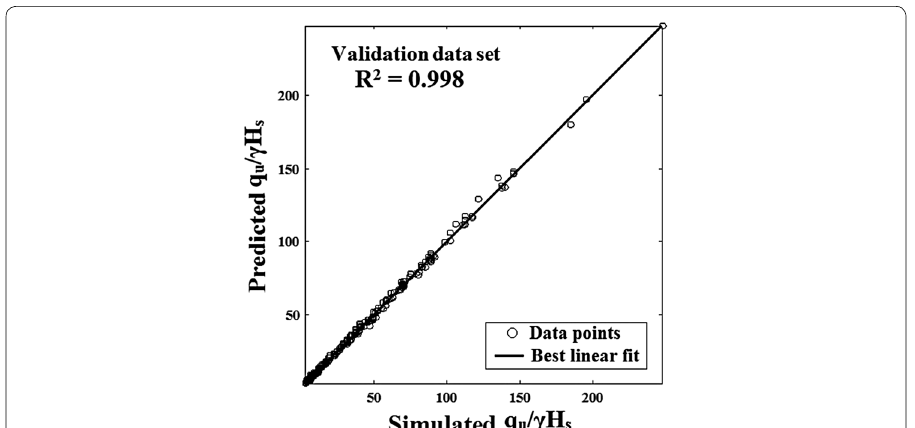
Fig. 18 Performance of neural network model for validation phase